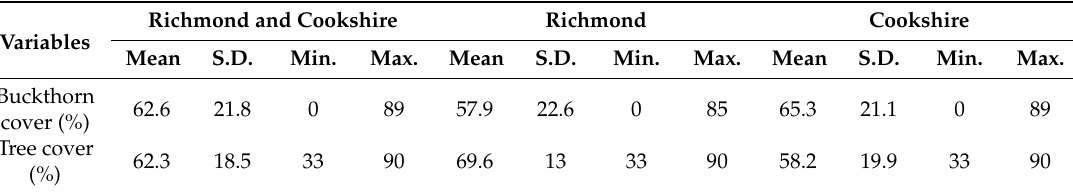
Table 2. Descriptive statistics of glossy buckthorn cover and tree canopy cover from plots measured in Richmond and Cookshire .